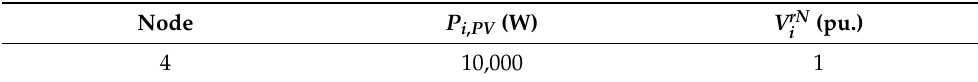
Table 4. The details of PV